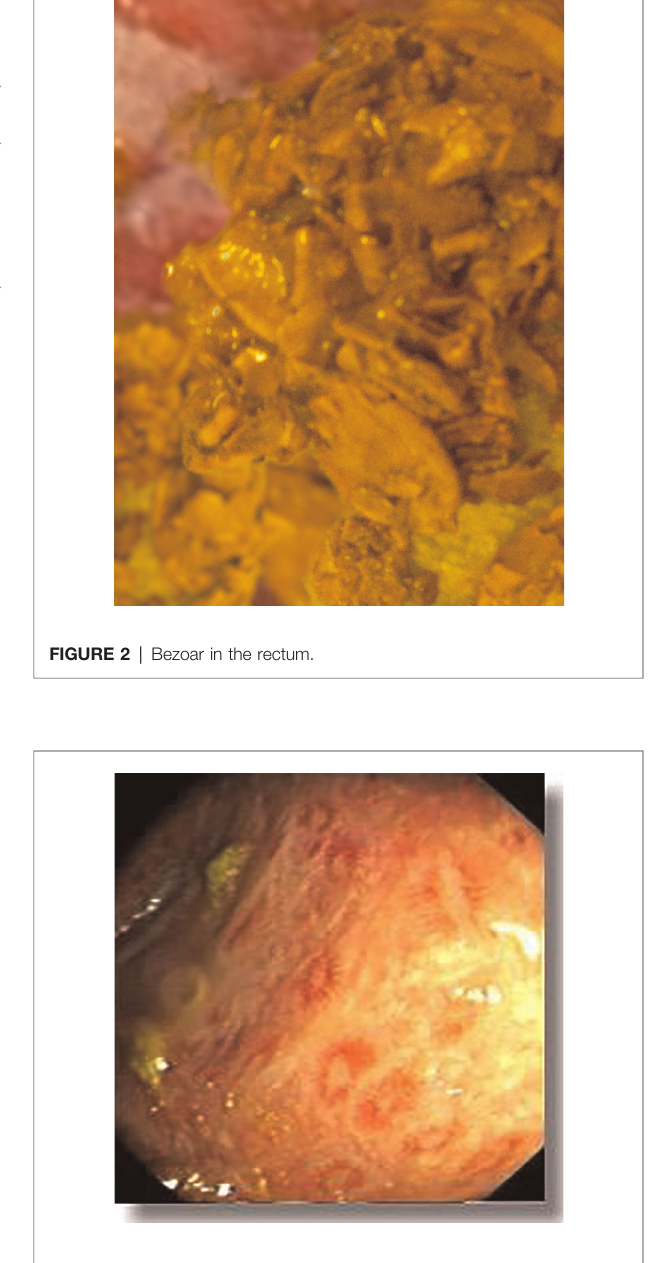
FIGURE 3 | Rectal wall after disimpaction.